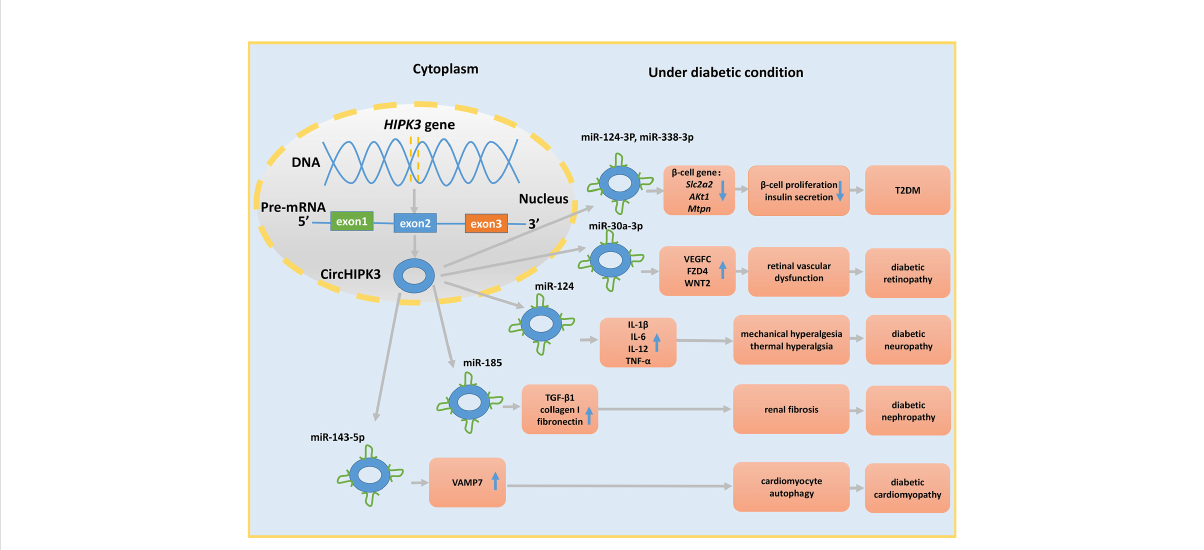
FIGURE 3 The miRNA sponge role of circHIPK3 in DM and its complications. CircHIPK3 is derived from exon 2 of the HIPK3 gene and acts as a sponge for various miRNAs to regulate cell function, further contributing to the development of DM and its